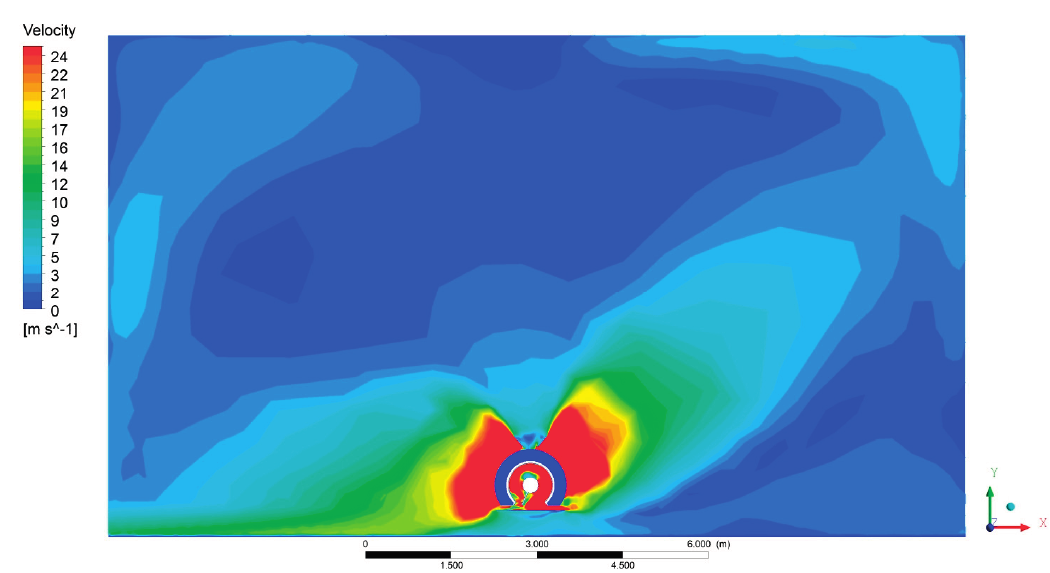
Figure 10. Air velocity obtained with CFD model in rear section of sprayer (C). Both the front and rear fans are activated. The fans are set to position 3.